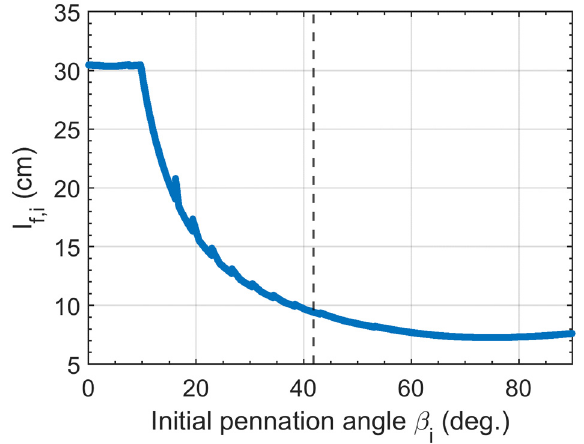
Figure 11. Variation in initial fiber length with initial pennation angle with the pinned boundary condition. The dashed vertical line indicates the boundary between fiber contraction-limited (left of the line) and fiber rotation-limited (right of line) topologies.